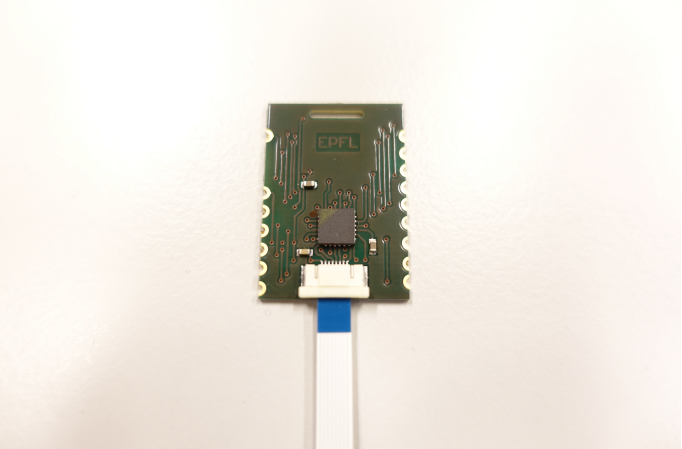
Figure 9. PCB with ANTIGONE packaged